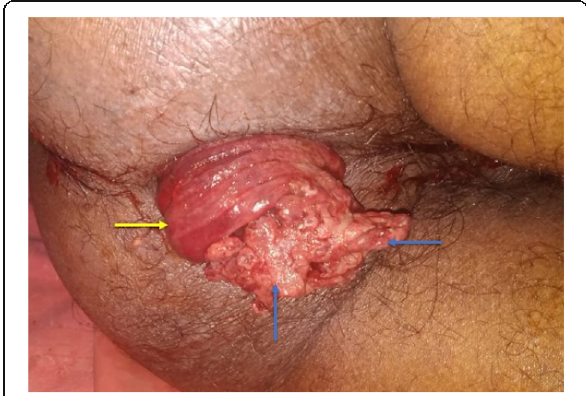
Fig. 1 Prolapsed sigmoid-rectal intussusception (yellow arrows) with mass lesion as lead point (blue arrows)